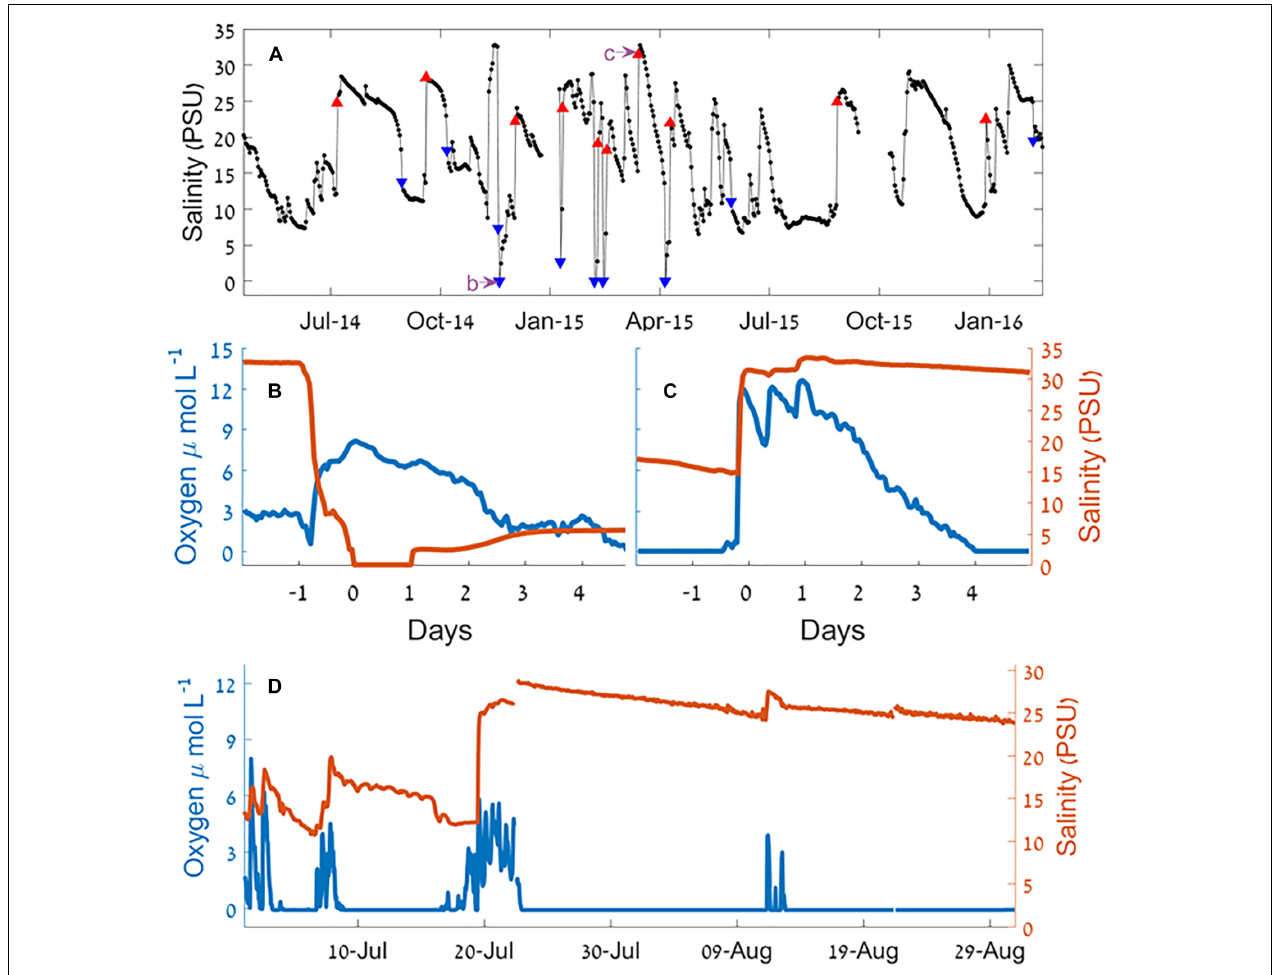
FIGURE 4 | Salinity and oxygen at the Alexander estuary bottom water 350 m upstream from the estuary mouth during a sandbar breach. (A) Time series of daily medians of salinity January 2014 to August 2016. The blue triangles represent the 10 largest salinity decrease events and the red triangles represent the 10 largest salinity increase events. The purple arrows point the timing of panels (B,C) . (B,C) A 6-day time series of sandbar breach causing salinity decrease (B) and increase (C) and the effect on oxygen concentration. (D) A time series of salinity and oxygen concentration during the summer of 2014. For a detailed view of the marked events, see Supplementary Figures S4 , S5